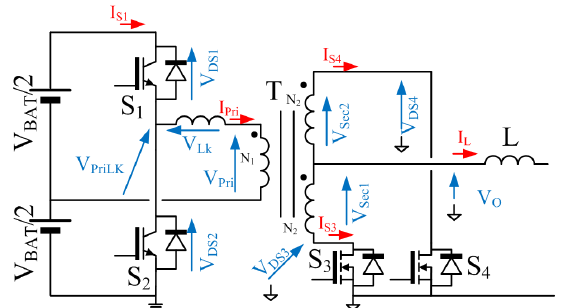
Figure 10. Half-bridge current-source (HBCS) converter equivalent circuit, including the overall leakage inductor at the primary side of the transformer.